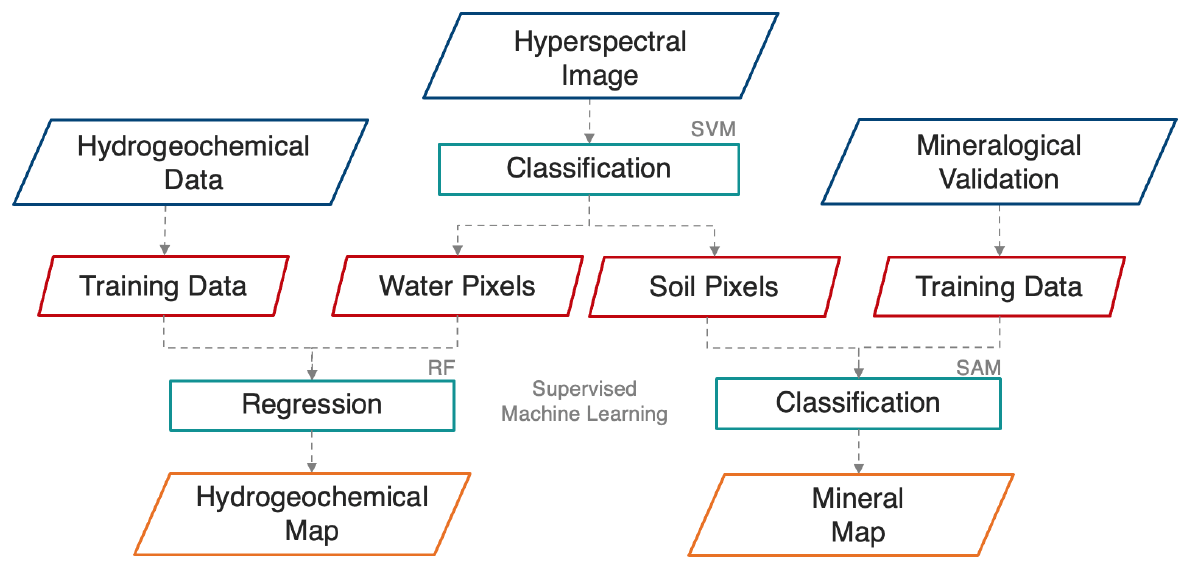
Figure 5. Implemented processing chain over the hyperspectral images for